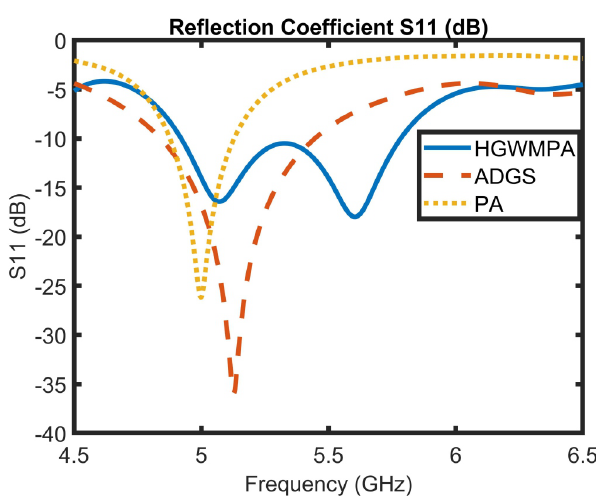
TABLE 1. Dimensions of the proposed HGWMPA